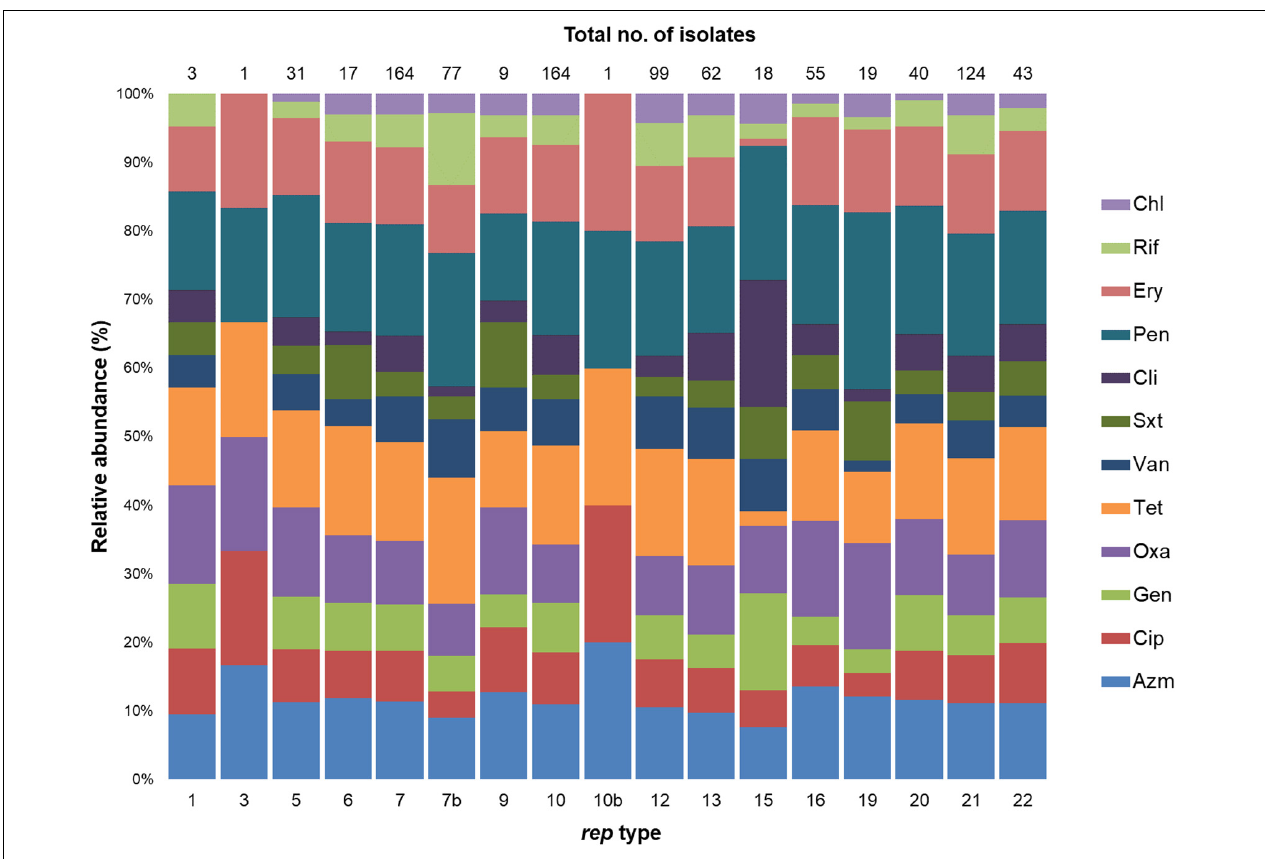
FIGURE 6 | Stacked column bar graph showing the relative abundance of S. aureus isolates with antimicrobial resistance according to rep type. Antimicrobial resistance is differentiated by color as